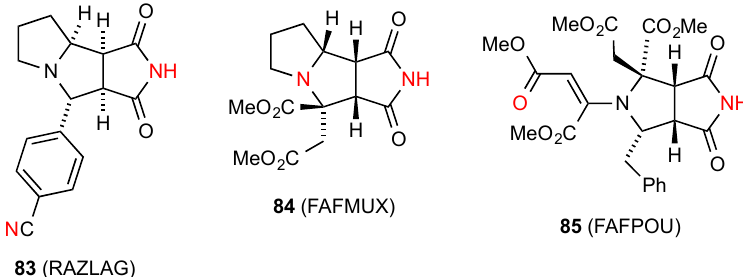
Figure 29. Five-membered ring-fused succinimides showing patterns E and F.